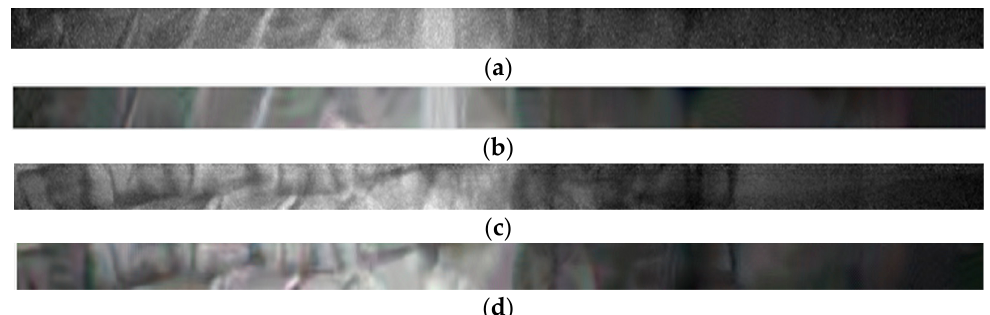
Figure 12. The denoising effect of BM3D on sequential image. ( a ) Original image 1, ( b ) The denoising result of image 1, ( c ) Original image 2, ( d ) The denoising result of image 2.